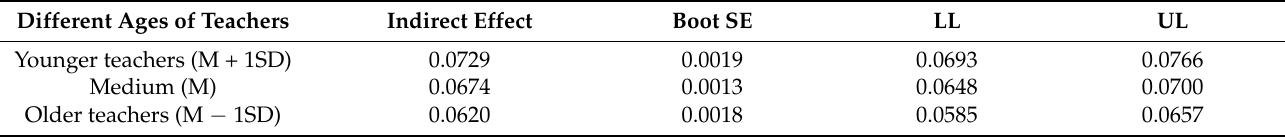
Table 5. Conditional indirect effect of TCOT on POLO through TR for teachers of different